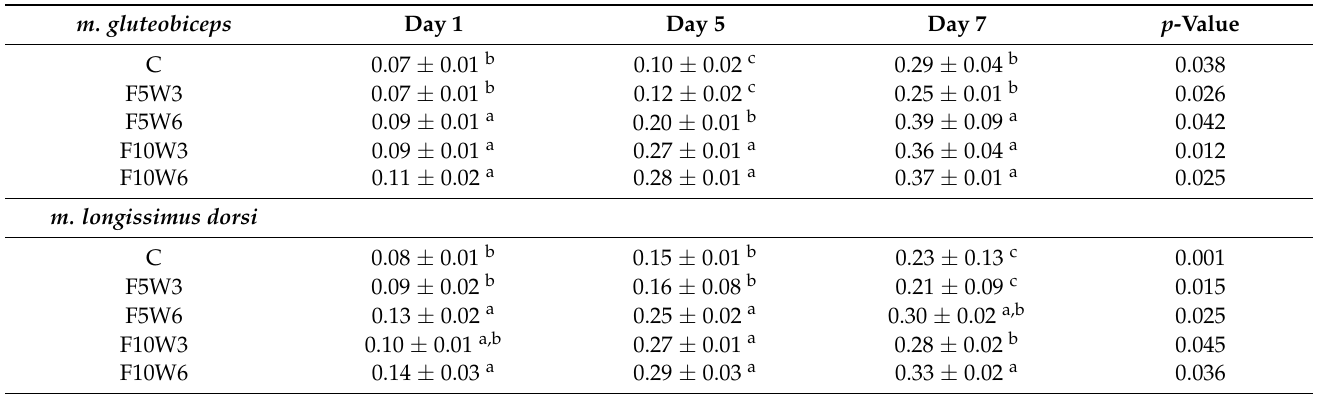
Table 5. Lipid oxidation determined as MDA (malondialdehyde) expressed as mg.kg − 1